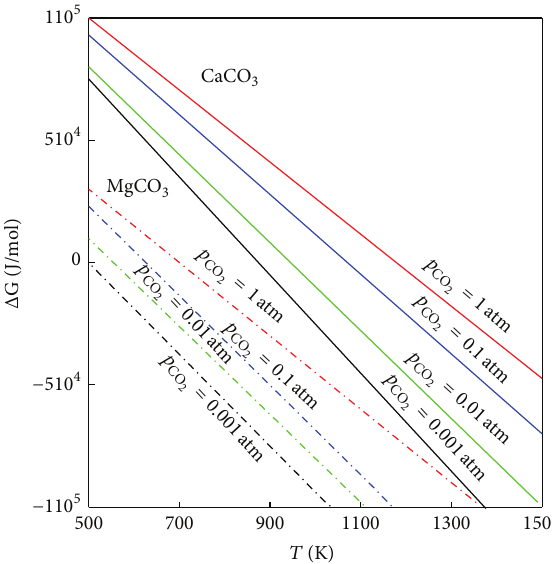
Figure 4: The Gibbs free energy changes of the decomposition reaction of CaCO 3 and MgCO 3 at 𝑝